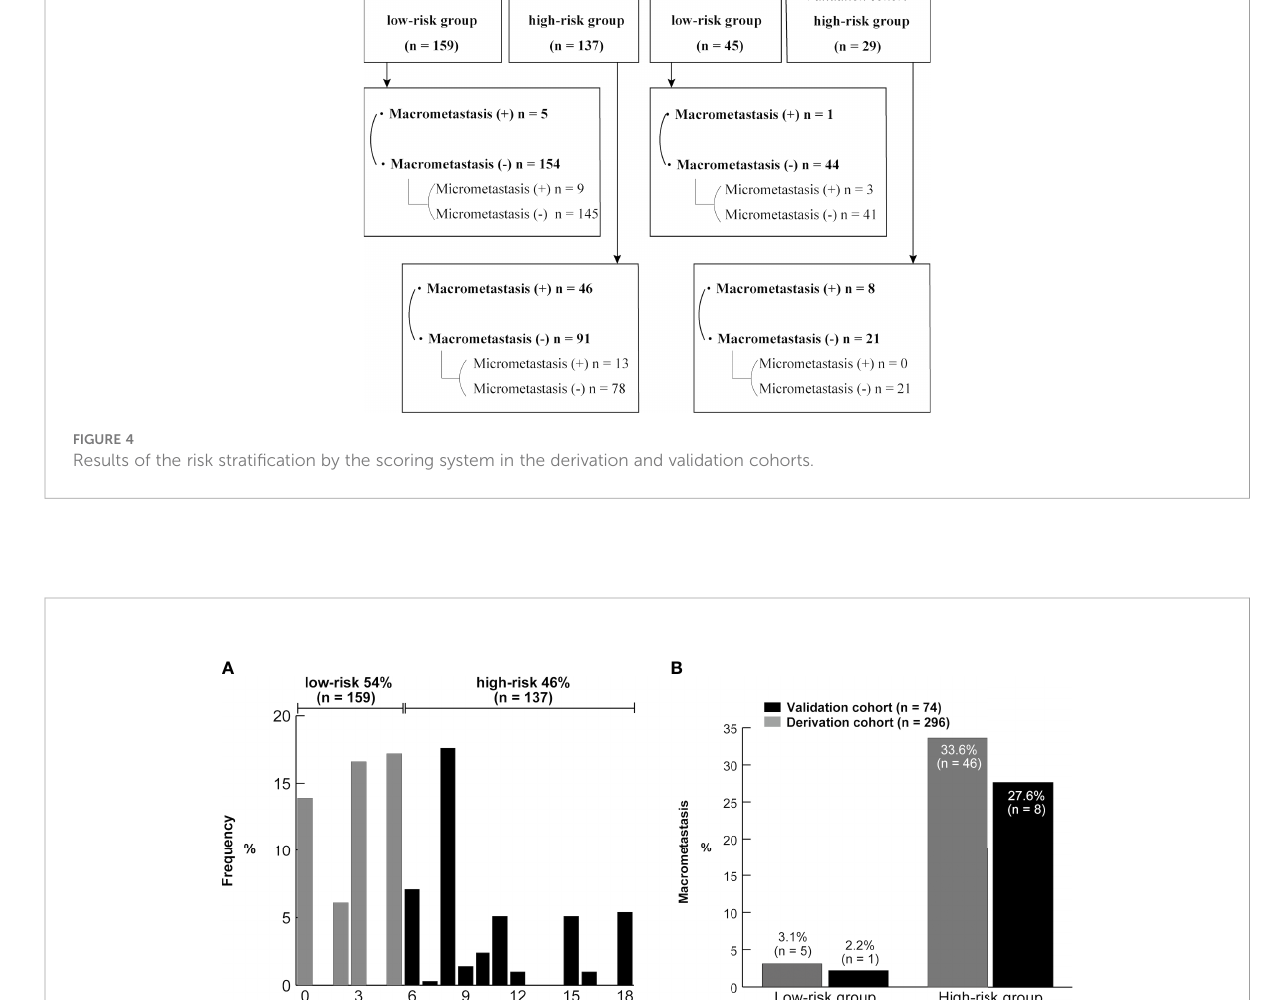
FIGURE 5 (A) Distribution of the risk scores from the derivation cohort. The brackets show the proportion of patients in the low-risk (0 – 5) and high-risk groups ( ≥ 6). (B) Frequency of the axillary lymph node macrometastasis according to the risk groups in the two